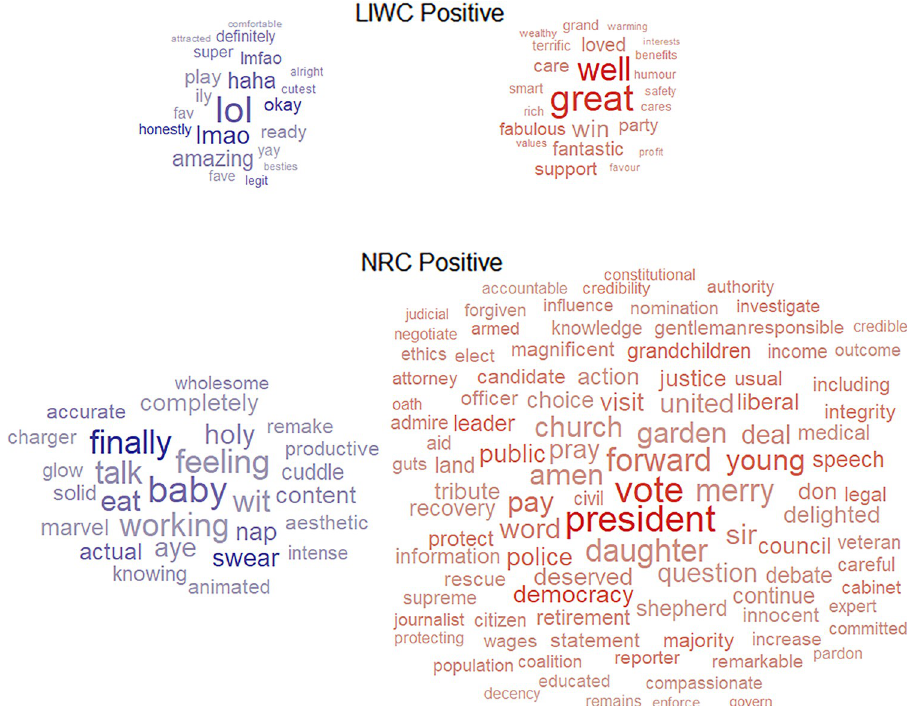
Fig 2. Unique positive affect words from LIWC and NRC that are correlated with age. Size of a word corresponds to its average frequency in the dataset, the colour corresponds to the correlation with older age: the more blue, the more negative correlation; the more red, the more positive